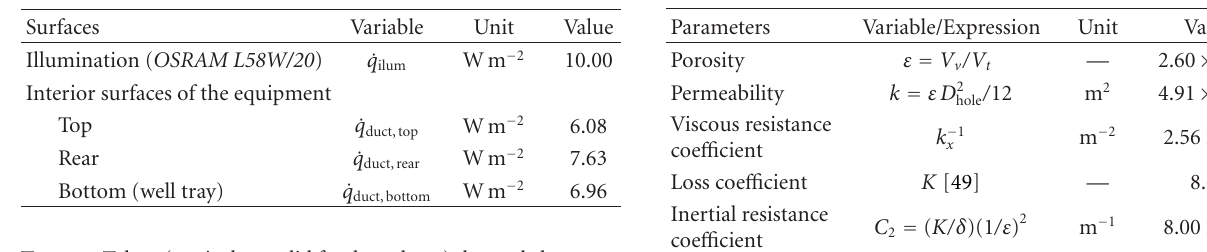
Table 5: Tylose (equivalent solid food products) thermal character- istics.